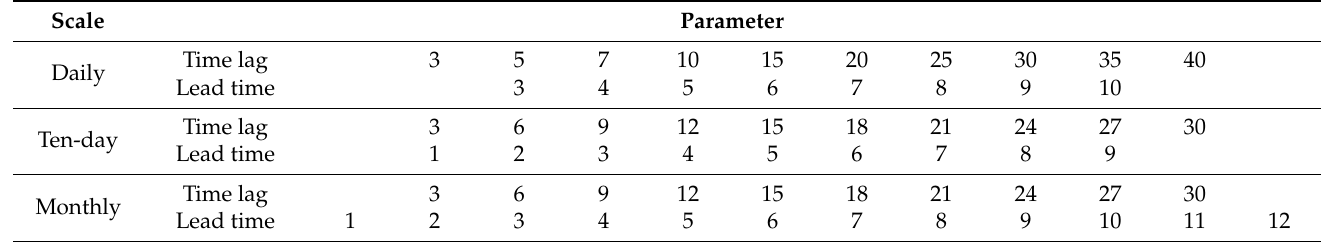
Table 2. The time-lags and lead-times setting of models at daily, ten-day, and monthly scales.